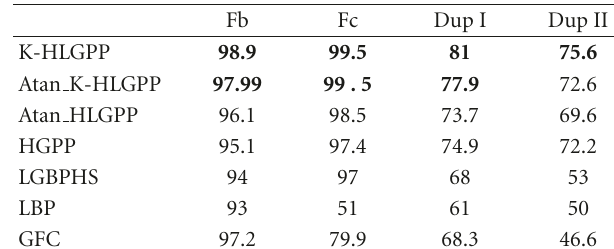
Figure 6: Relationship between the number of histogram bins and recognition rate (Atan K-HGLXP). Table 3: Rank-1 recognition rate comparisons with other state-of- the-art results tested on FERET probe sets according to the standard FERET evaluation